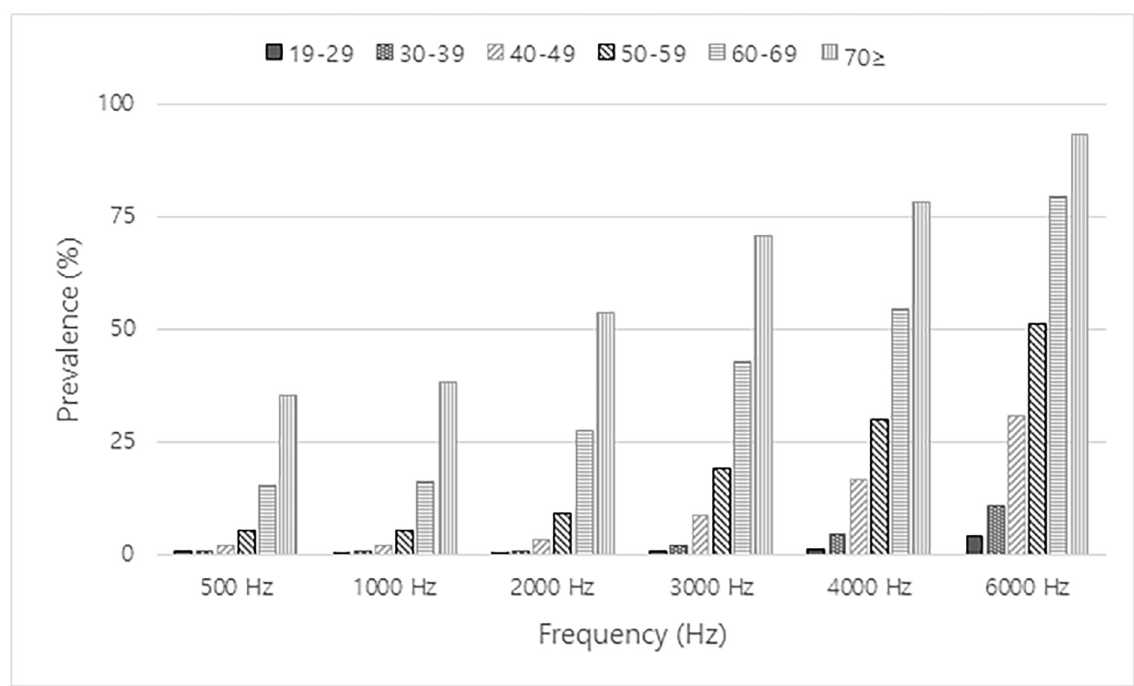
Fig 2. Prevalence of hearing impairment (more than 25 dB in the better ear) at each frequency by decade age (2009–2012). The prevalence was steeply increased with age at all frequencies.